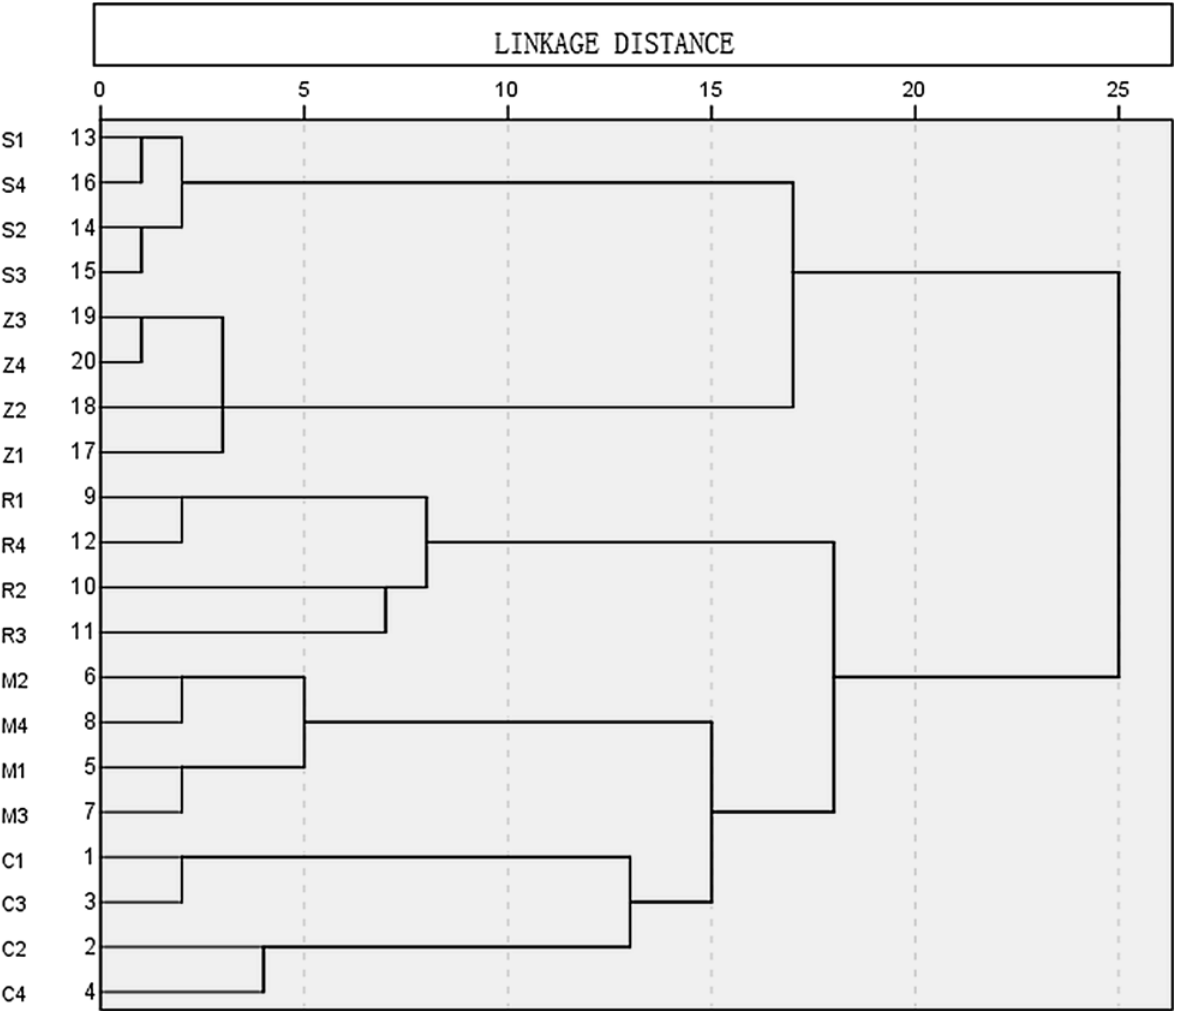
Fig 4. Dendrogram of wines of five cultivars (M, Merlot; C, Cabernet Sauvignon; R, Ruby Cabernet; Z, Zinfandel; S, Syrah), (4 replicates of each), based on multidimensional analysis of metabolites detected by 1 H NMR